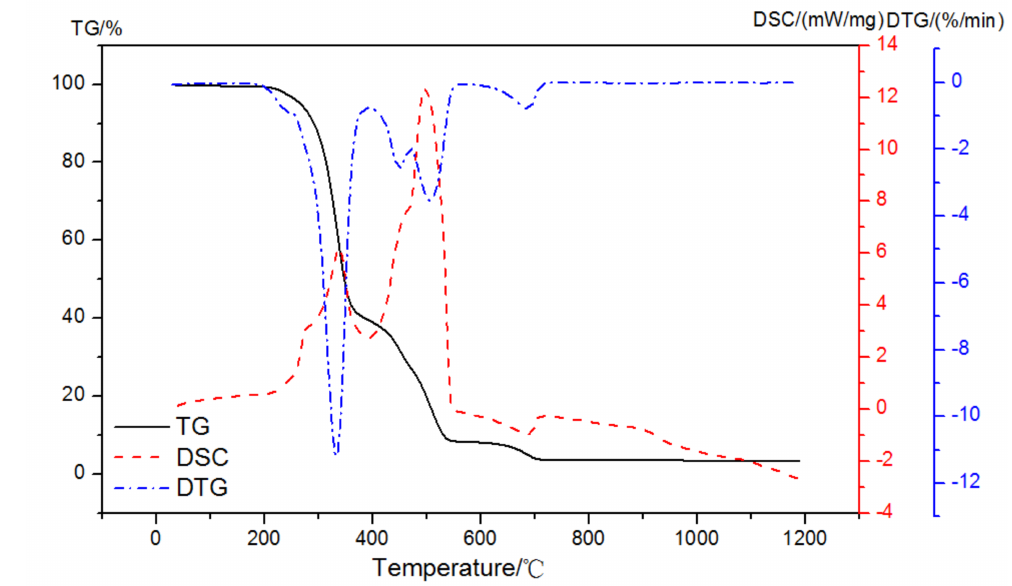
Figure 6. TG-DSC-DTG curves of EVA in an air atmosphere.